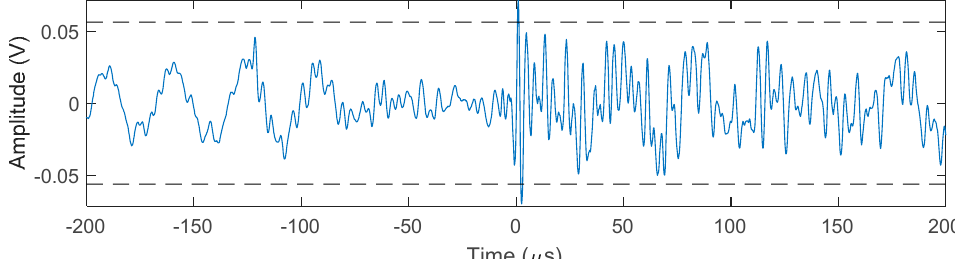
Figure 3. Typical AE hit for this experiment, recorded on channel 1 and associated with the AE event at x = − 5.89 cm and y = − 1.24 cm.